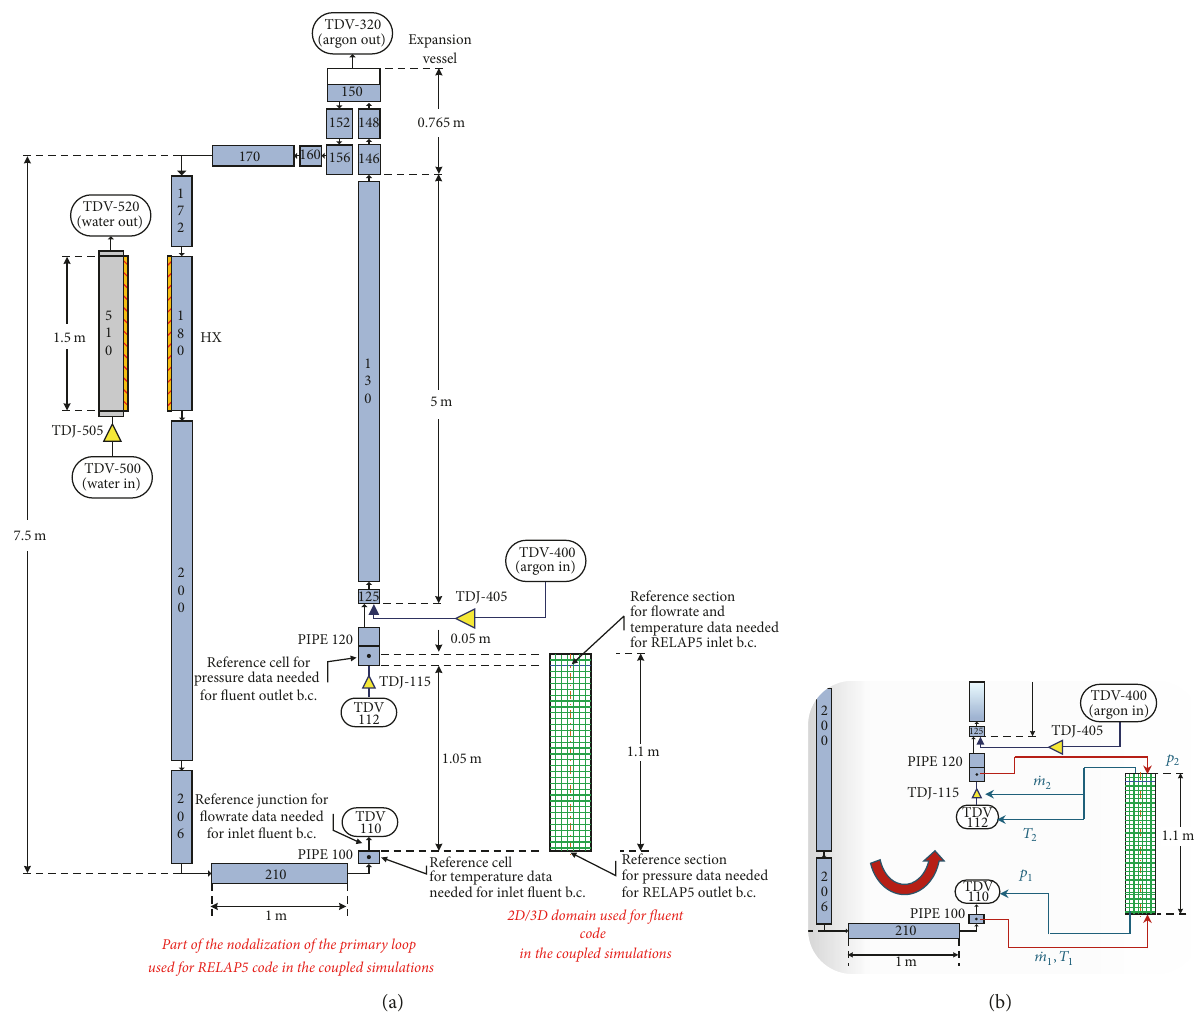
Figure 5: NACIE loop computational domain (a); codes exchanged data (b).